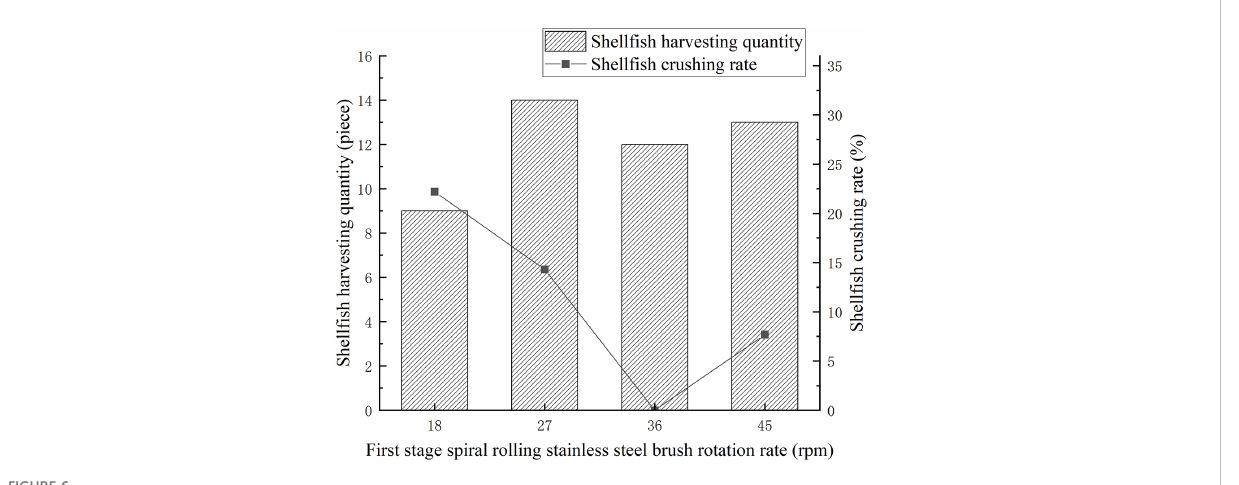
FIGURE 6 In fl uence of fi rst-stage brush rotation rate on shell fi sh